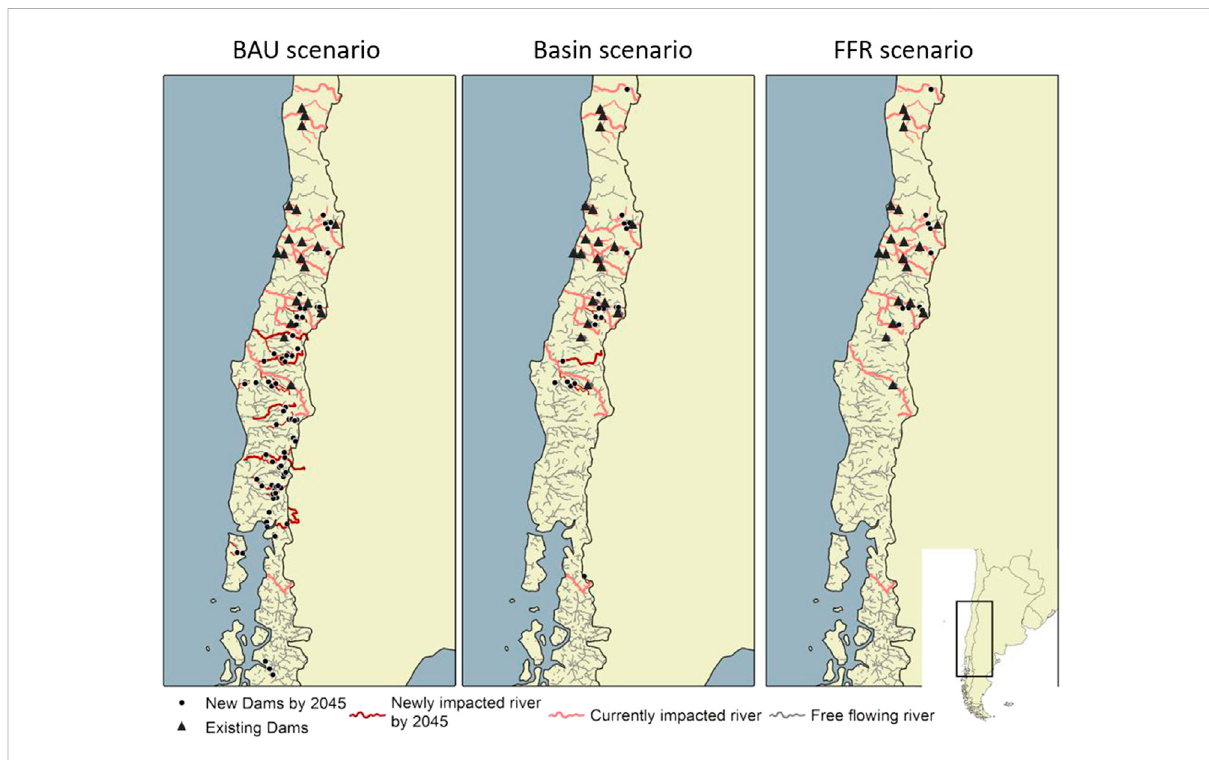
FIGURE 7 Location of dams and free- fl owing rivers in Chile under three power system scenarios. Used with permission from Opperman et al.